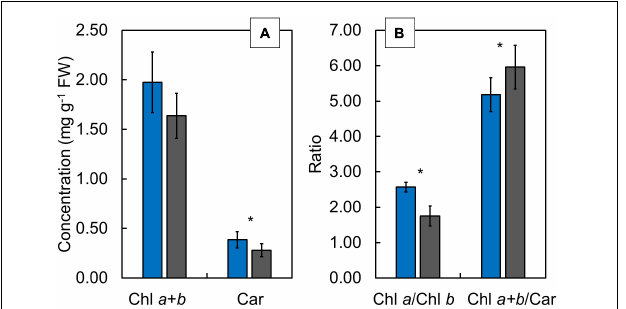
FIGURE 6 | The Chl a + b (mg/g FW) and carotenoids (Car; mg/g FW) (A) , as well as Chl a/b and Chl a + b /Car ratios (B) , determined in the Japanese knotweed ( Reynoutria japonica Houtt.) leaves exposed to constant low light (blue bars) and fluctuating light (gray bars). The values are represented as means ± SD. The asterisk (*) represents a significant difference at p ≤ 0.05 (using the Student’s t